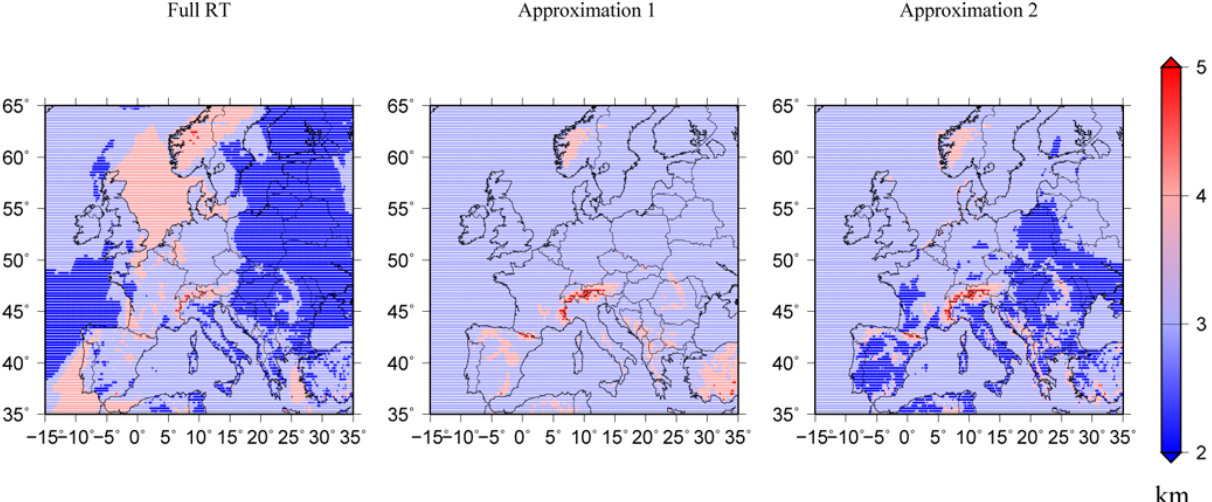
Fig. 6. Distribution over Europe of the altitude of maximum sensitivity of surface-6km ozone columns for full RT (left panel), approxima- tion 1 (central panel) and 2 (right panel), for the 20 August 2009,